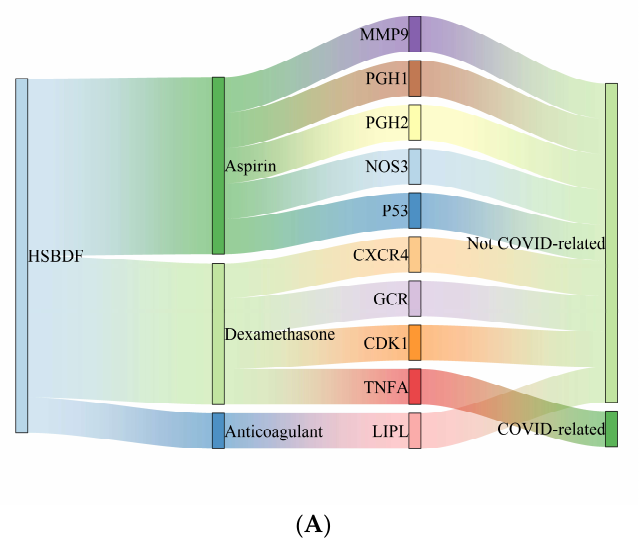
Figure 4. ( A ) Interaction between HSBDF plus WM and COVID-related proteins in a Sankey dia- gram. ( B ) Interaction between QFPDT plus WM and COVID-related proteins in a Sankey diagram. ( C ) Interaction between NRICM101 plus WM and COVID-related proteins in a Sankey diagram.